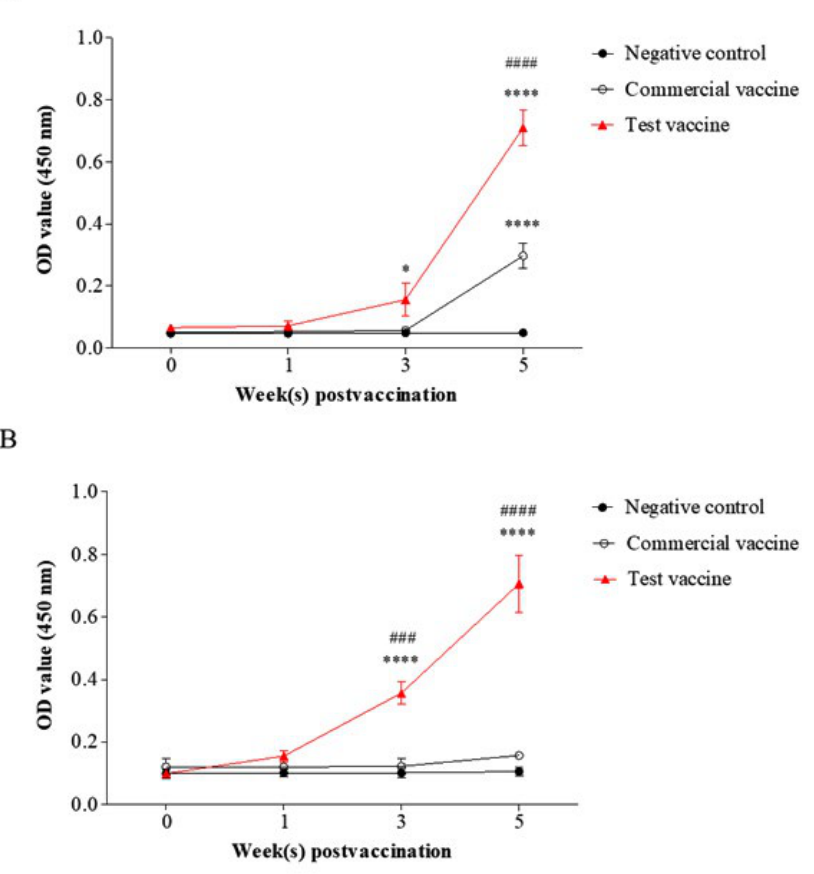
Fig. 2. Specific antibody responses against Mhp (A) and rP97 (B) in the test vaccine ( ▲ ), the commercial vaccine (o), and the negative control groups (•). Data are presented as means ± SD. The asterisks and hashes indicate significant differences (* p < 0.05; **** p < 0.001, compared with the negative control group. ###, ### p < 0.001, compared with the commercial vaccine group). OD value (450 nm), absorbance at 450